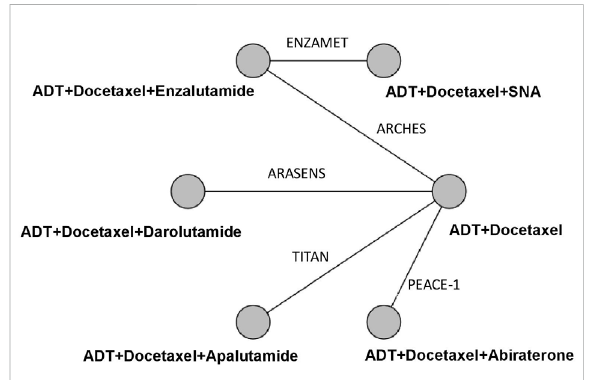
Network Graph of Trials Comparison. The nodes (circles) represent comparative therapy, and the edges (lines) show which therapies have been compared. The labels on the edges represent the names of RCTs comparing therapies. SNA: Standard nonsteroidal